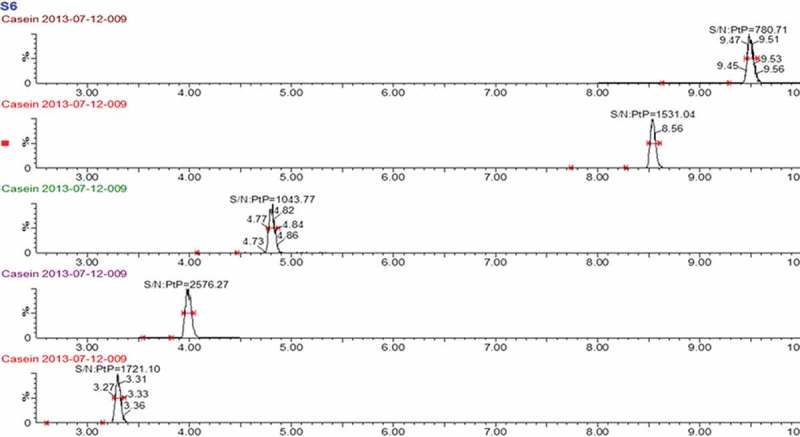
MRM chromatograms of the quantitative product ion spectra from the selected precursors of the target peptides with the signal-to-noise ratio, from top to bottom: DMPIQAFLLYQEPVLGPVR, GPFPIIV, EMPFPK, VLPVPQK and AVPYPQR.